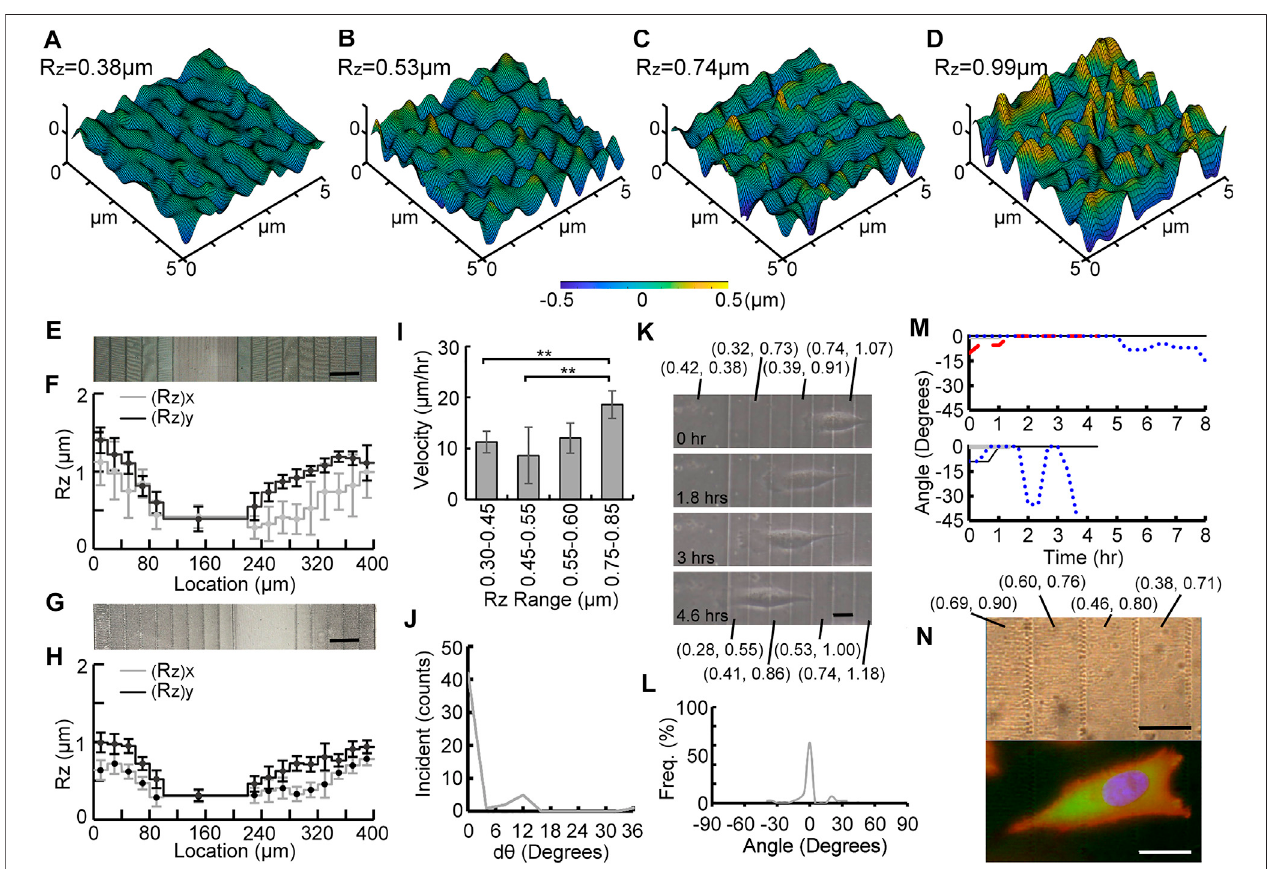
FIGURE 5 | Experimental results of the G 20 substrate. (A – D) confocal scanned pro fi les of four different roughness areas on G 20 . SEM micrographs and distributions ofR z values ofOrmocomp ® substrates (E – F) and PPsubstrates (G – H) .Measuredvelocity ondifferentroughness ranges ofthesubstrate (I) ,the changeof orientation angle d θ (J) , time-lapse images of a migrated cell (K) , percentage of occurrence frequency of orientation angle (L) , traces of orientation angle of monitored cells ( n = 7) (M), and phase contrast and fl uorescent micrographs of a migrating cell on the G 20 substrate (N) , where nuclei, F-actin, and focal adhesion complex were stained with H33342 (Blue), rhodamine phalloidin (orange – red), and anti-vinculin antibody and anti-paxillin antibodies (green) (scale bar = 40 μ m).